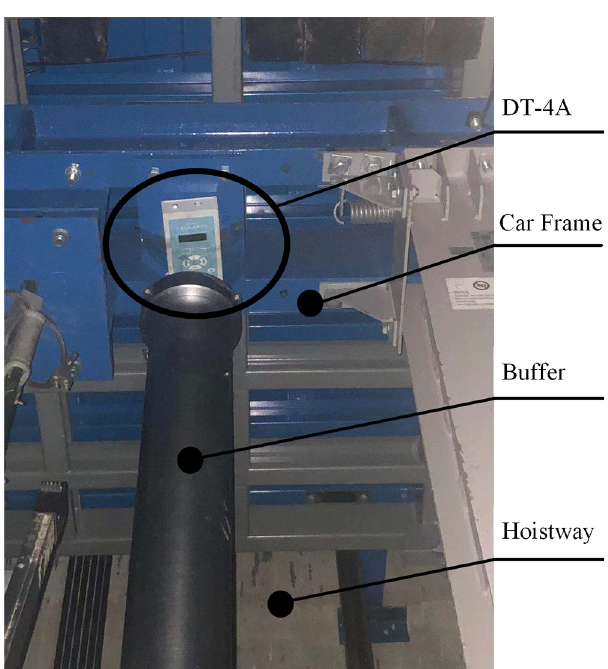
Fig. 8. The measuring points of the car frame.